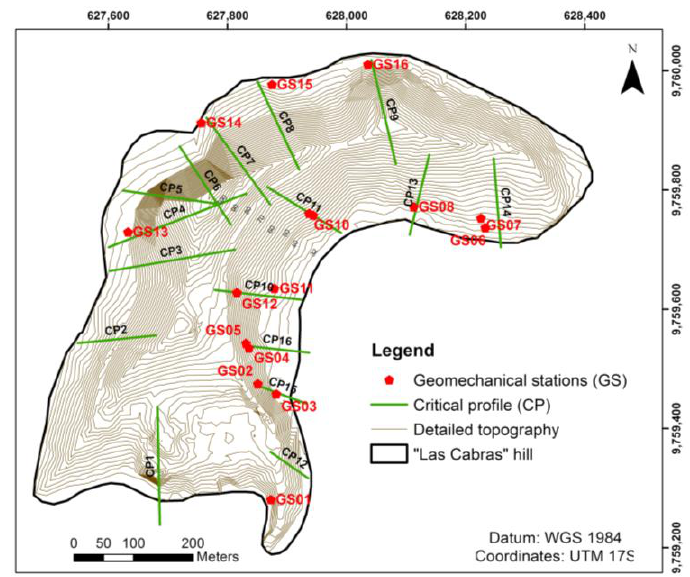
Figure 9. Critical profiles for stability assessment.